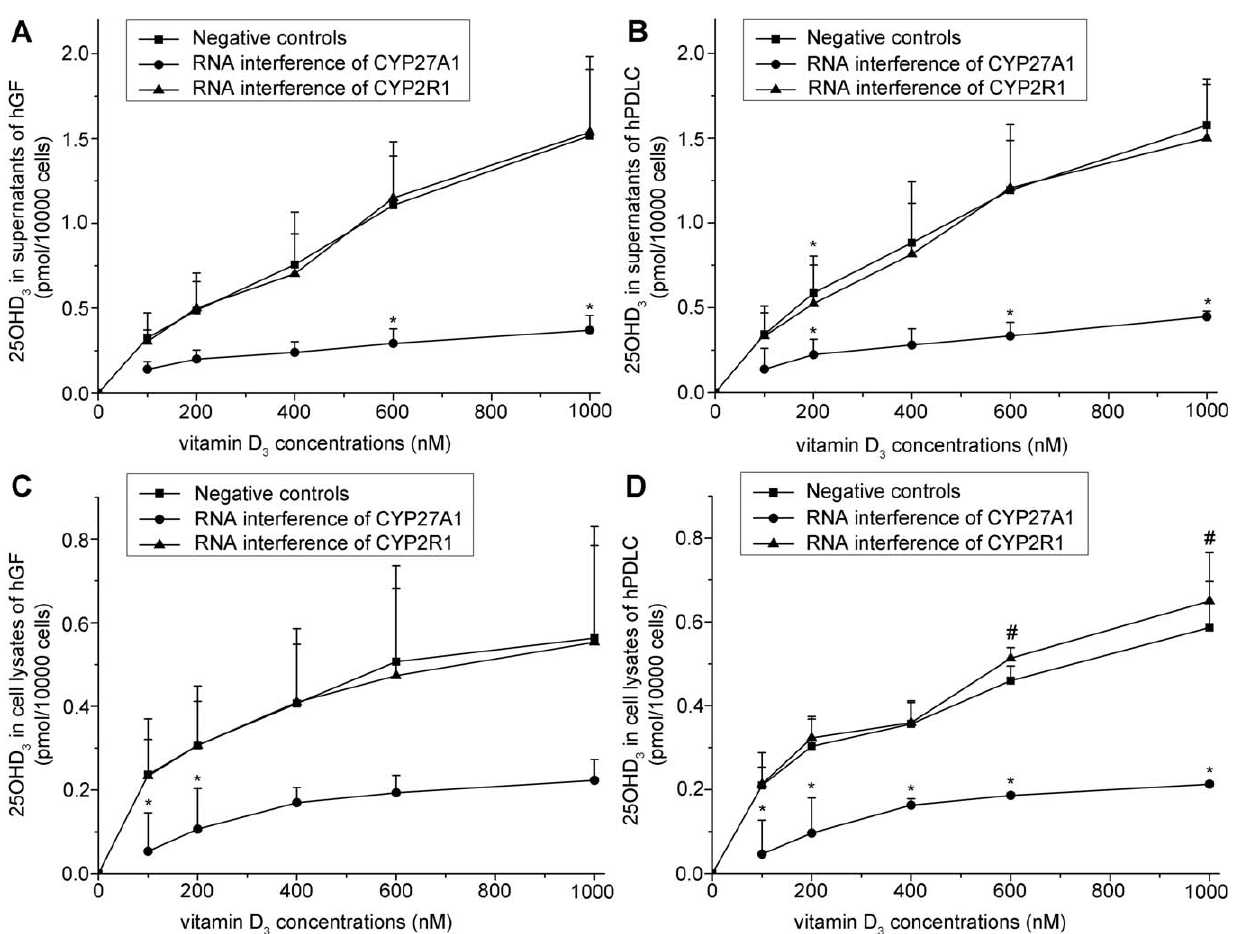
Figure 6. Effect of knockdown of 25-hydroxylases on 25OHD 3 generation. hGF and hPDLC from donors 2, 4 and 5 were treated with vitamin D 3 at various concentrations indicated in the figure for 12 h after transfection with a siRNA oligonucleotide for CYP27A1, a siRNA oligonucleotide for CYP2R1, or a non-silencing control. 25OHD 3 production was measured in supernatants of hGF (A), supernatants of hPDLC (B), cell lysates of hGF (C), and cell lysates of hPDLC (D). When CYP27A1 or CYP2R1 was not knocked down, the production of 25OHD 3 increased with an increasing concentration of 25OHD 3 . When CYP27A1 was knocked down in hGF and hPDLC, the generation of 25OHD 3 decreased significantly compared to when CYP27A1 was not knocked down. When CYP2R1 was knocked down in hGF (A, C), the generation of 25OHD 3 was not significantly different from that when CYP2R1 was not knocked down. When CYP2R1 was knocked down in hPDLC (B, D), the generation of 25OHD 3 was only slightly different at some time points from that when CYP2R1 was not knocked down. The data are presented as the mean 6 SE. * hGF or hPDLC generated significantly less 25OHD 3 with the same amount of added vitamin D 3 when CYP27A1 or CYP2R1 was knocked down ( p , 0.05). # hGF or hPDLC generated significantly more 25OHD 3 with the same amount of added vitamin D 3 when CYP27A1 or CYP2R1 was knocked down ( p , 0.05).